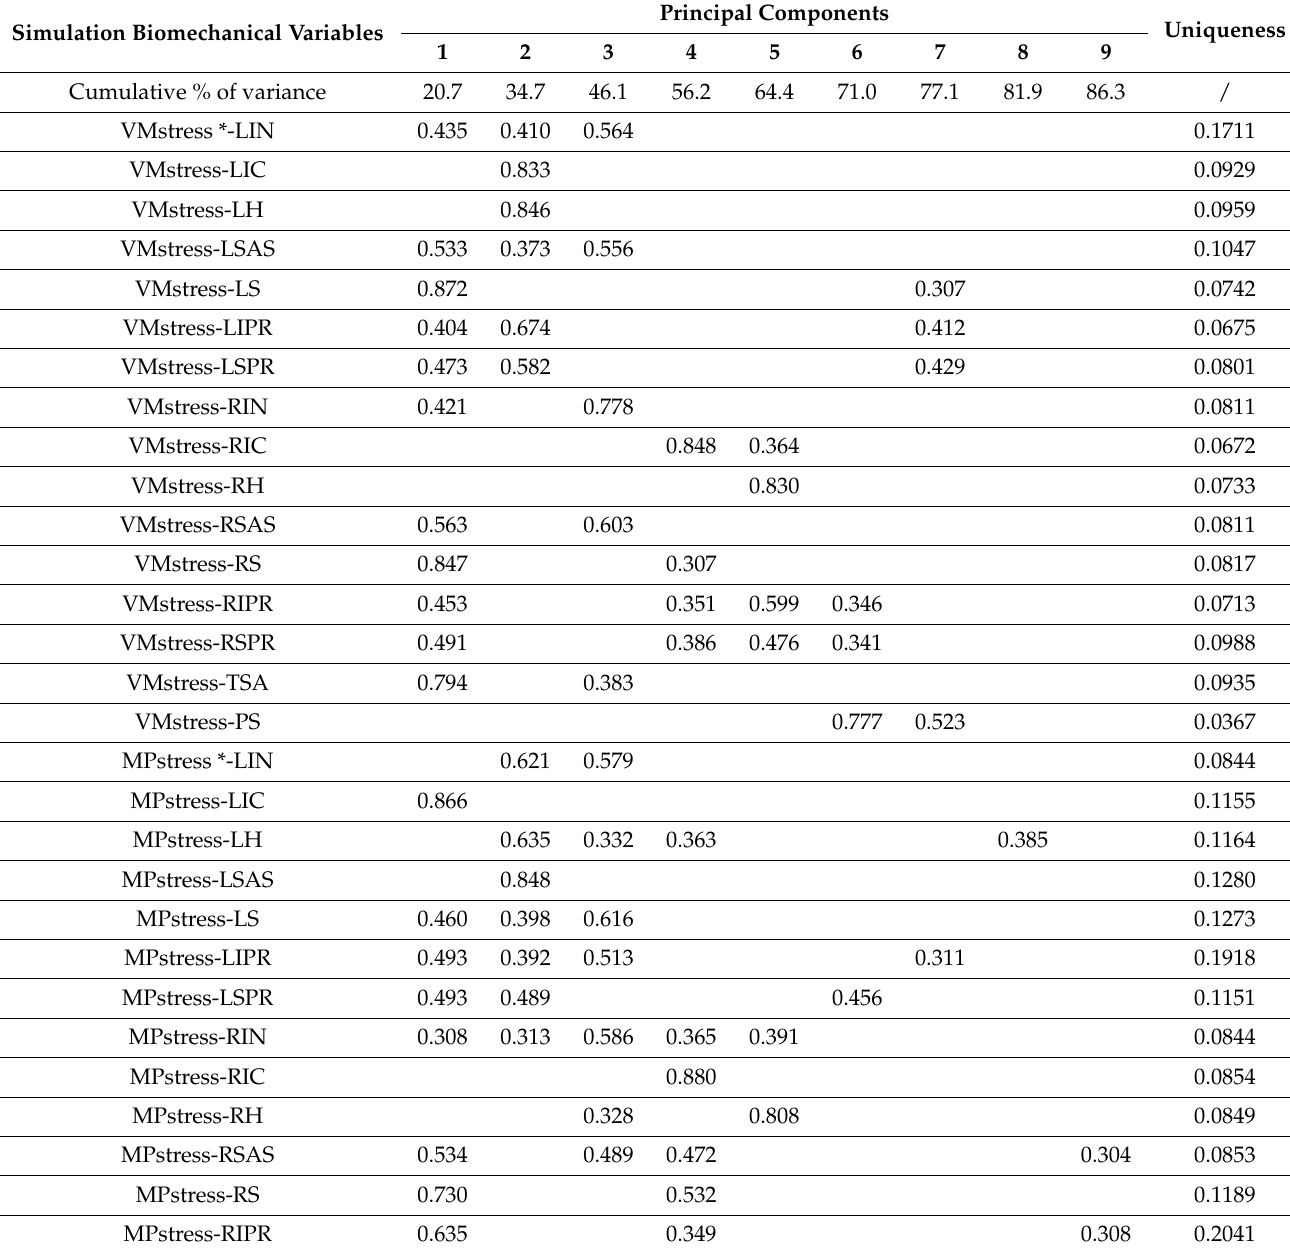
Table 4. The principal component analysis of the total 42 biomechanical variables of the pelvis fracture